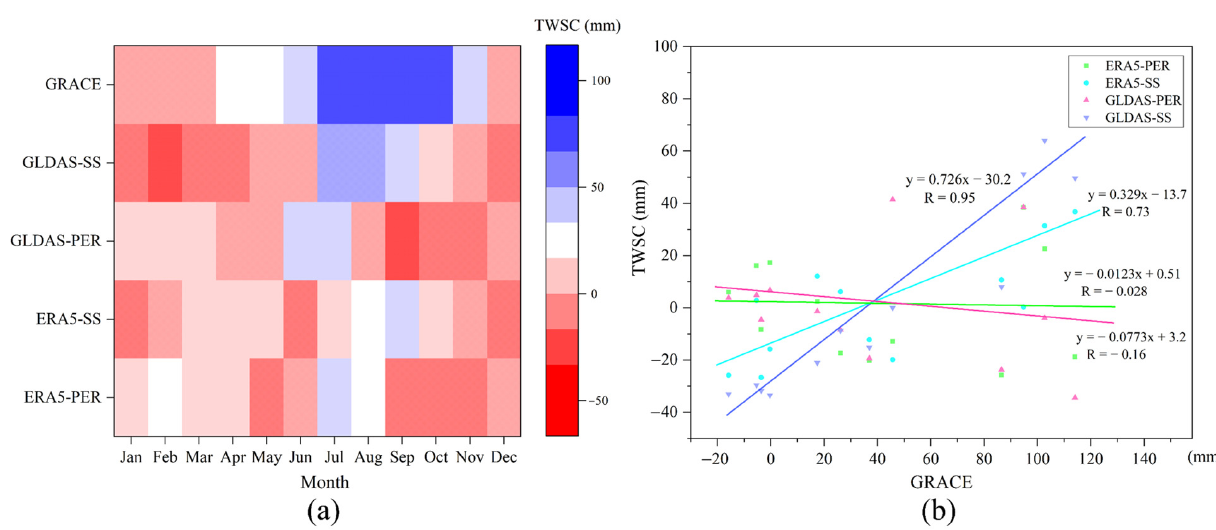
Figure 3. Comparison of multi-year monthly average value of TWSC based on ERA5 and GLDAS with the results of GRACE ( a ) and correlation coefficients ( b ). ERA5-PER represents the multi-year monthly average TWSC estimated by the PER method based on ERA5; ERA5-SS represents the multi-year monthly average value of TWSC estimated by the SS method based on ERA5; GLDAS-PER represents the multi-year monthly average value of TWSC estimated by the PER method based on GLDAS; GLDAS-SS represents the multi-year monthly average value of TWSC estimated by the SS method based on GLDAS; GRACE represents the multi-year monthly average value of TWSC derived from GRACE.